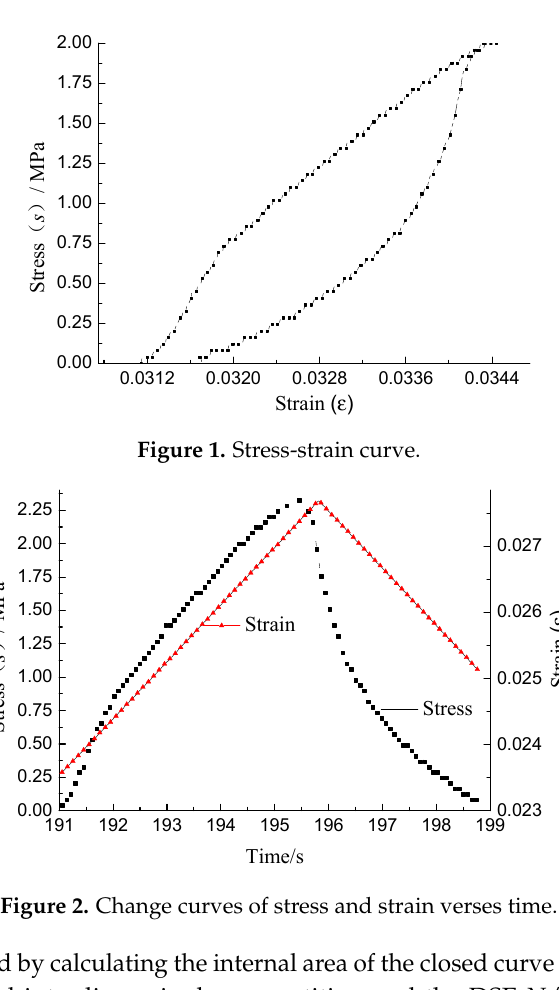
Figure 2. Change curves of stress and strain verses time.